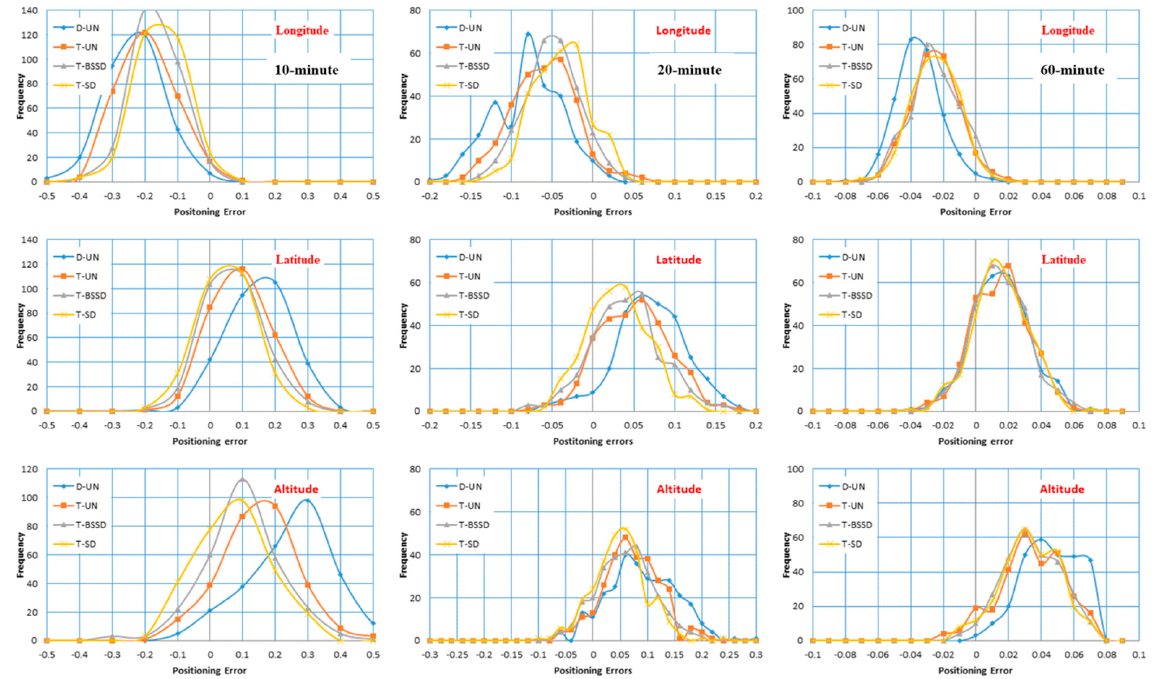
Figure 6. Positioning error distribution computed after 10, 20 and 60 min in longitude, latitude and altitude. Figure 6. Maximum and RMSE values of the positioning errors for different kinematic PPP solutions.